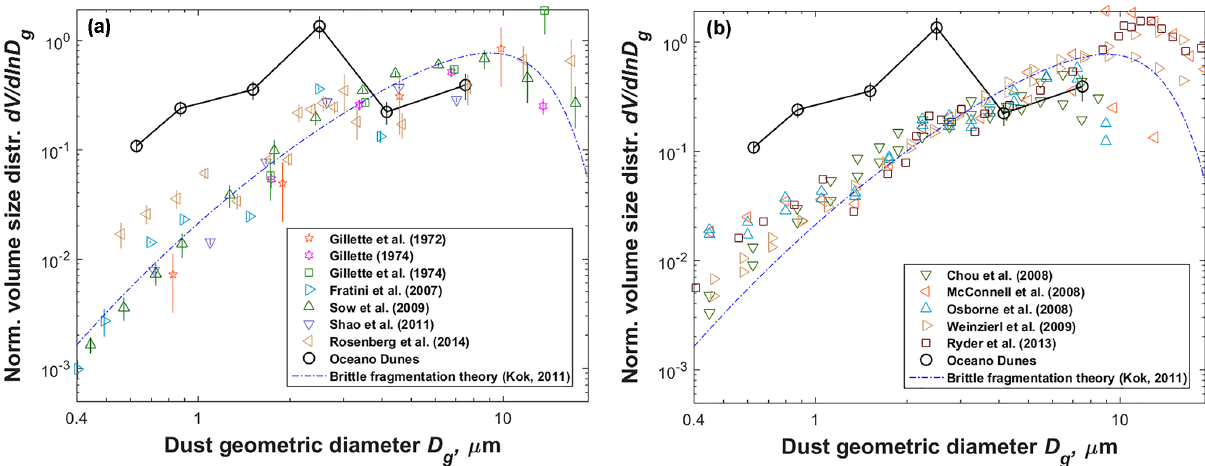
Figure 3. Normalized volume particle size distribution (PSD) of dust at emission as a function of the dust aerosol geometric diameter averaged over all measurements at Oceano (black open circles). Plotted for comparison are measurements compiled by Kok et al. (2017) of (a) the emitted dust PSDs from non-sandy soils in the US (Gillette et al., 1972, 1974; Gillette, 1974), China (Fratini et al., 2007), North Africa (Sow et al., 2009; Rosenberg et al., 2014), and Australia (Shao et al., 2011) and (b) in situ aircraft measurements of dust-dominated PSDs close to the Saharan source regions. Note that these measurements are normalized using the procedure described in Kok (2011) and Kok et al. (2017), which differs somewhat from the procedure used for the Oceano data (see Sect. 2). Also plotted for comparison is the brittle fragmentation theory (dashed–dotted blue lines) on the PSD of emitted dust generated by aggregate fragmentation (Kok, 2011). Error bars on the Oceano measurements were obtained through error propagation (details in Supplement).